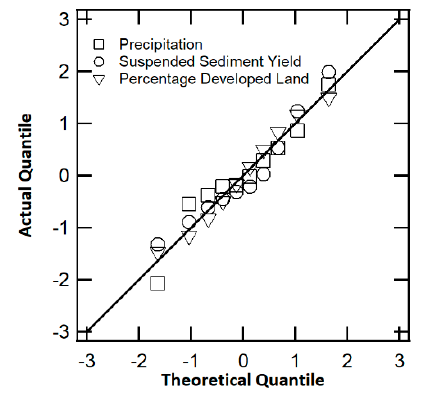
Figure 12. The Quantile–Quantile plot shows that variables are multivariate.